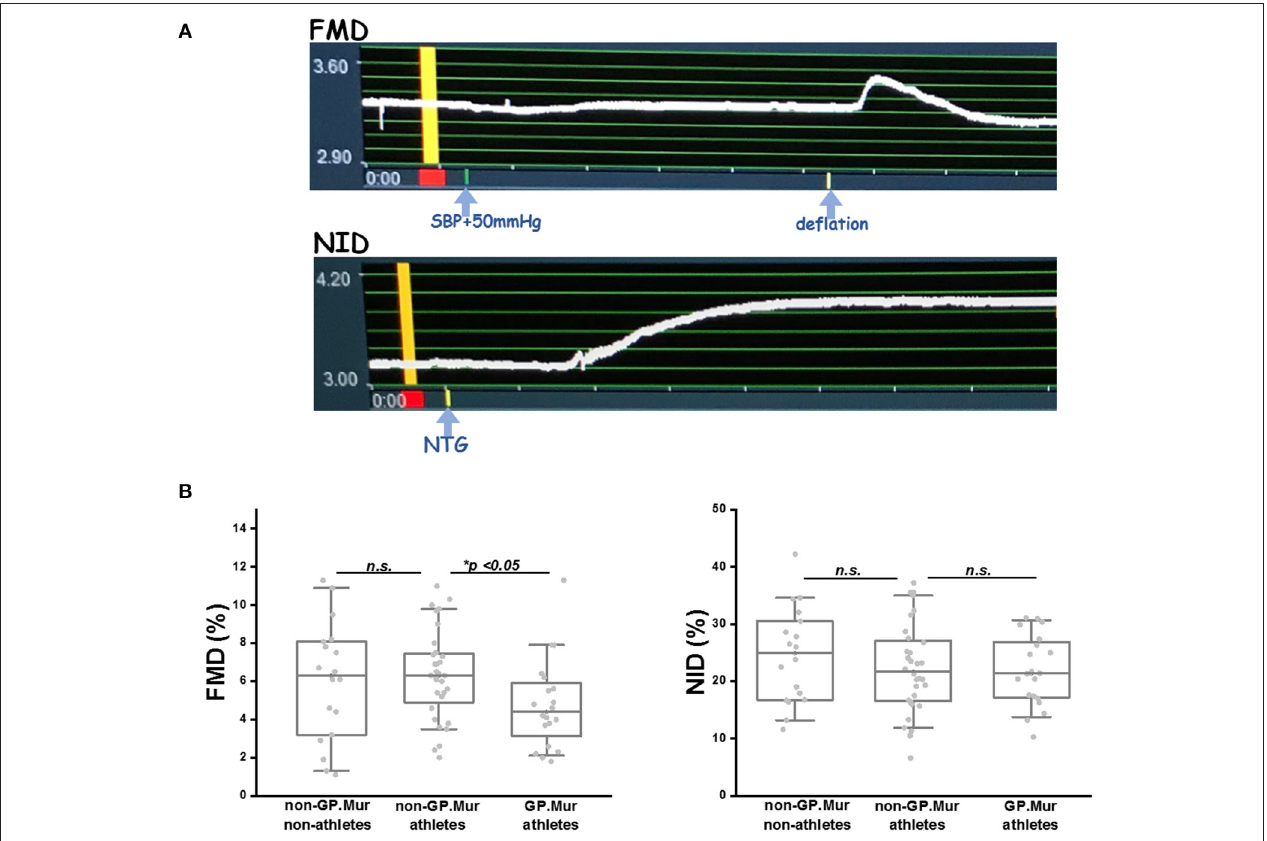
FIGURE 2 | FMD was significantly lowered in GP.Mur + male elite athletes than GP.Mur-negative athletes or nonathletes, whereas NID was not affected by GP.Mur expression. (A) TOP: An example of FMD captured by the eTRACKING program of Hitachi-Aloka ARIETTA 60. The diameter of the region tracked is shown at the y-axis (unit: mm). The recorded time is shown at the x-axis (unit: minute). The yellow bar indicates the baseline of the vessel diameter that was to be compared with the maximally dilated diameter of the same region for %FMD or %NID. BOTTOM: An example of NO-independent vasodilation. (B) FMD was compared among the three groups of subjects—GP.Mur athletes, non-GP.Mur athletes, and non-athletes. Each dot represented the datum of a subject. The box covered data ranging 25–75%; the line inside a box indicated the median value. Data between the paired groups were compared by two-sample t -test (* p < 0.05). RIGHT: Comparison of NID ( n. s ., n ot